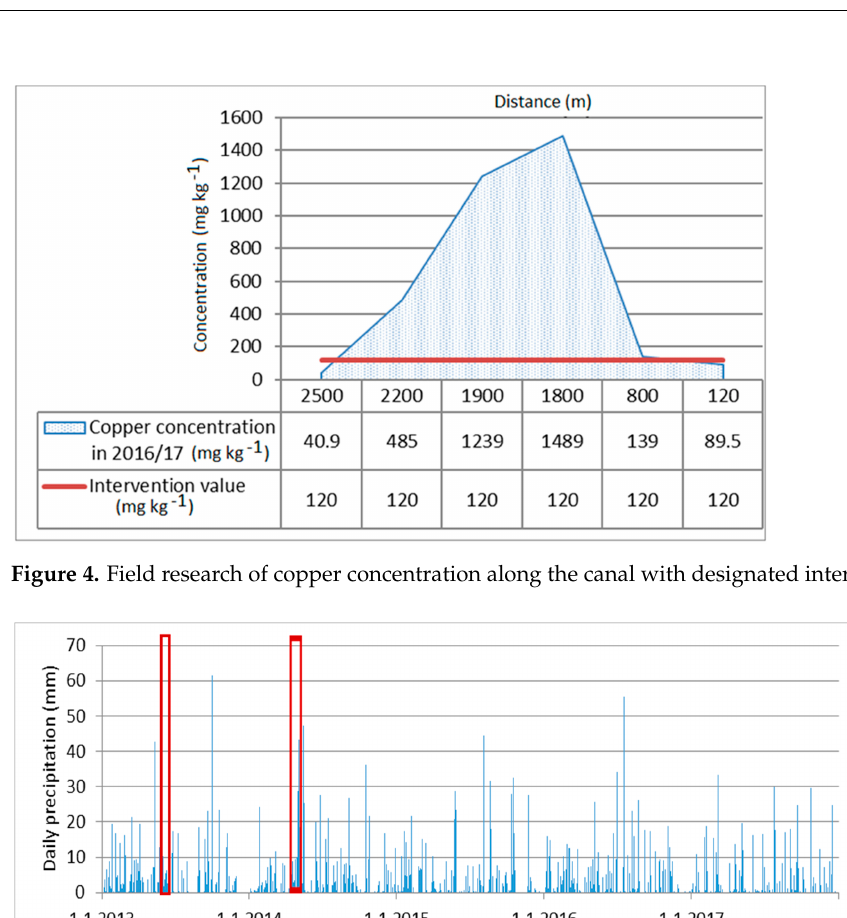
Table 1. Precipitation episodes relevant for sediment transport modelling. Figure 5. Daily precipitation of the period between January 2013 and December 2017 with designated tested precipitation episodes.